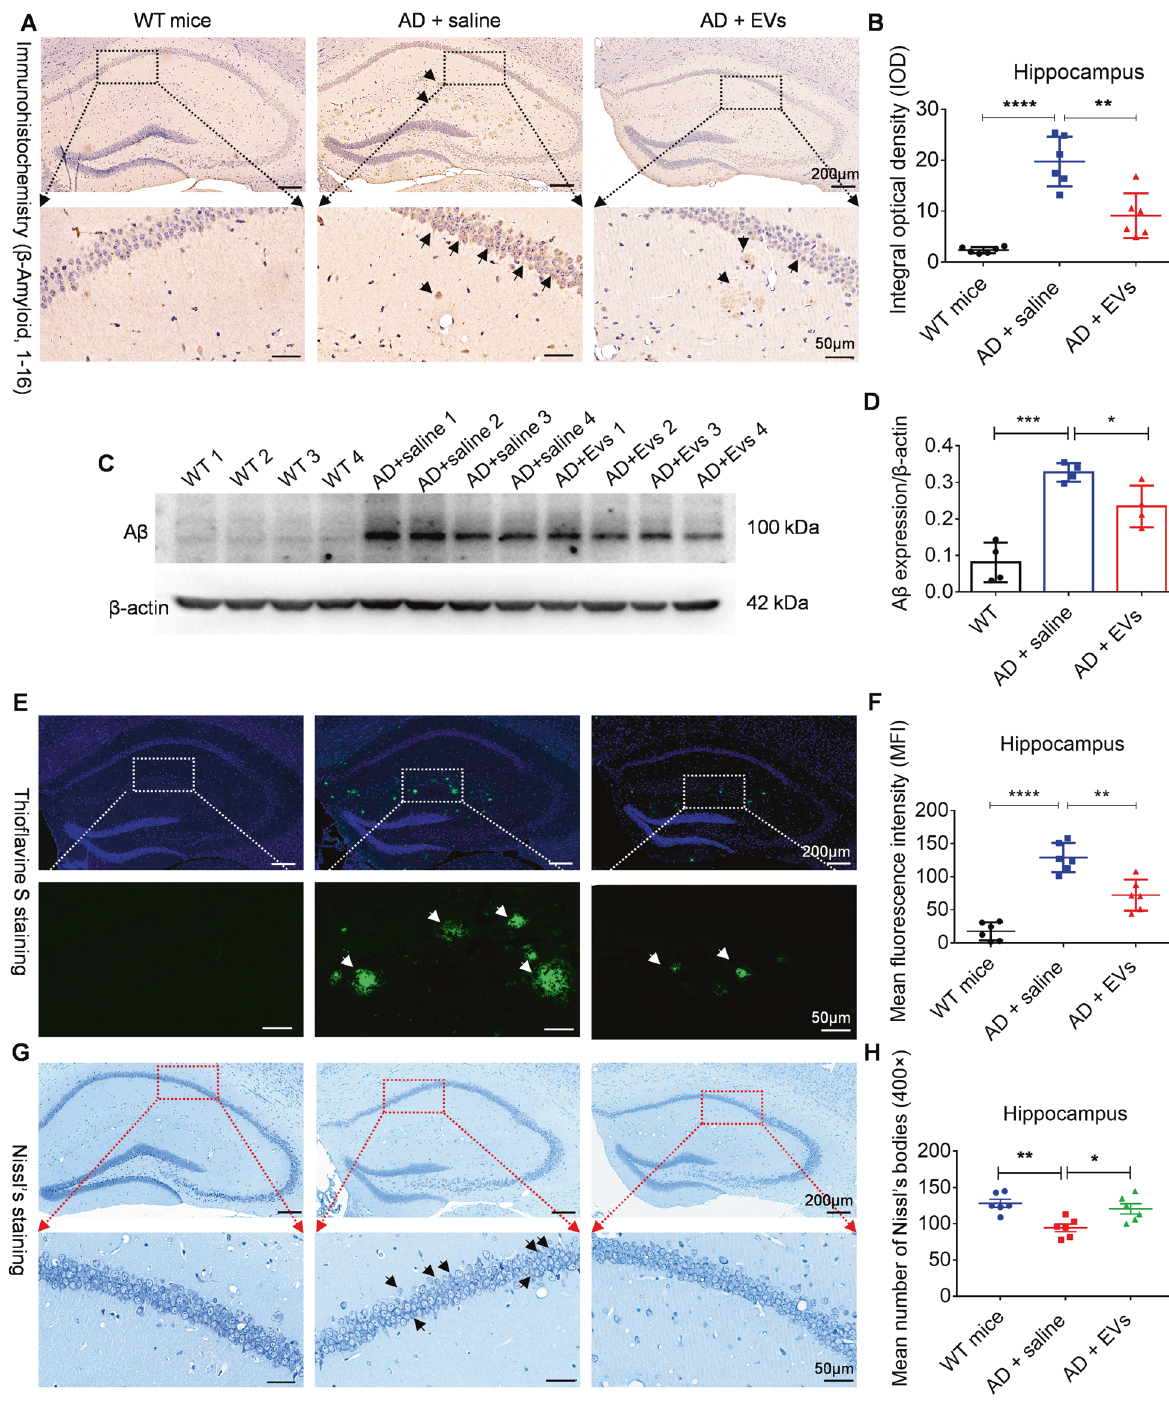
Fig. 2 Tail vein injection of MSC-EVs reduces the hippocampal A β aggregation and neuronal loss in APP/PS1 mice. A After MSC-EVs injection for 1 month, A β amyloid 1, 16 (A β ) immunohistochemistry images present the deposition of A β in the hippocampal regions of experimental mice (bar = 200 μ m); areas in squares (up), at higher magni fi cation (down) (bar = 50 μ m), show the distinction of A β aggregation in hippocampus (black arrowheads) among three groups. B Histogram display the integral optical density (IOD) of A β aggregation in the experimental groups ( n = 6). C Western blotting for the A β expression at 1 month in wild-type (WT) and APP / PS1 mice. D Statistic analysis show the relative expression of A β / β -actin in each group ( n = 4 per group). E Thio fl avine S staining present MSC-EVs-mediated changes in terms of A β aggregation in hippocampus (bar = 200 μ m), and in the down panel, A β deposition (green, white arrowheads) is shown at higher magni fi cation (bar = 50 μ m). F Plaque quanti fi cation in hippocampus appears as mean fl uorescence intensity (MFI) in each group ( n = 6 per group). G Representative images show the Nissl ’ s staining in the experimental groups (bar = 200 μ m), and the higher magni fi cation of square areas display the Nissl ’ s body loss in hippocampus of each group (bar = 50 μ m). H Histogram show the mean number of Nissl ’ s bodies (400×) in the experimental groups ( n = 6 per group). Quanti fi cation data are expressed with Mean ± SEM. The data meet normal distribution and the variance is homogeneous. * P < 0.05, ** P < 0.01, *** P < 0.001, **** P < 0.0001.